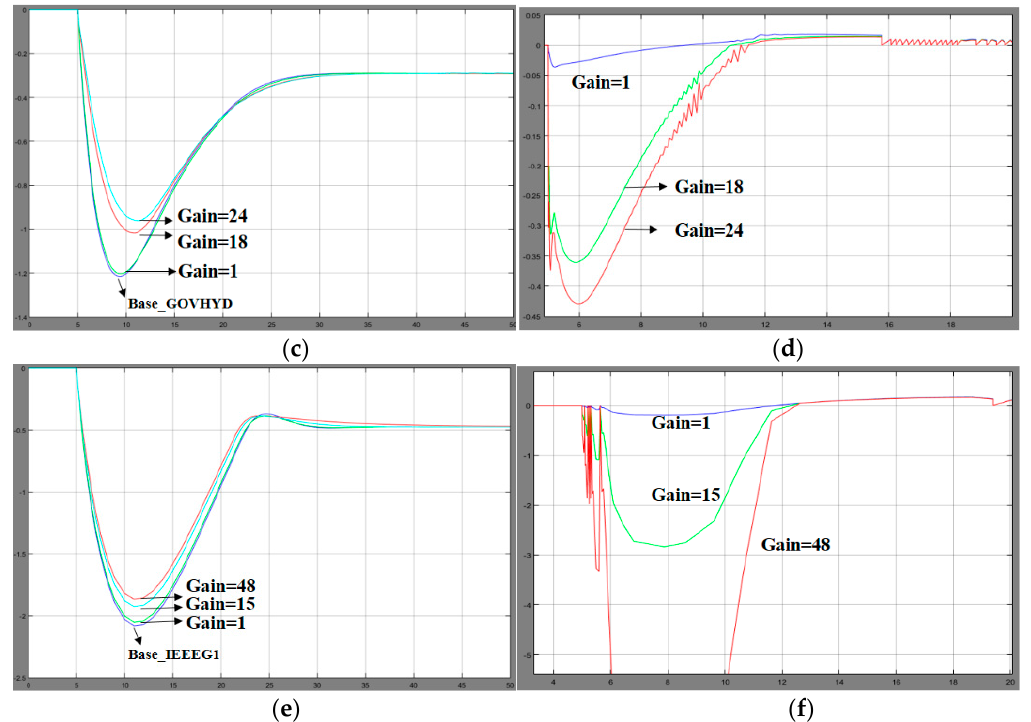
Figure 23. The frequency characteristics for an improved method: BESS frequency characteristics; ( a ) BESS frequency characteristics; ( b ) BESS error correction characteristics; ( c ) GOVHYD frequency characteristics; ( d ) GOVHYD error correction characteristics; ( e ) IEEEG1 frequency characteristics; ( f ) IEEEG1 error correction characteristics.